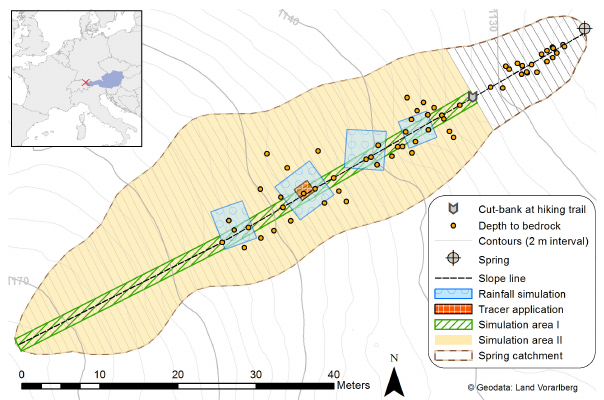
Fig. 1. Map of the study hillslope showing locations of field obser- vations and experimental plots as well as simulation areas consid- ered for model set-up. The inset shows the location of the study area within